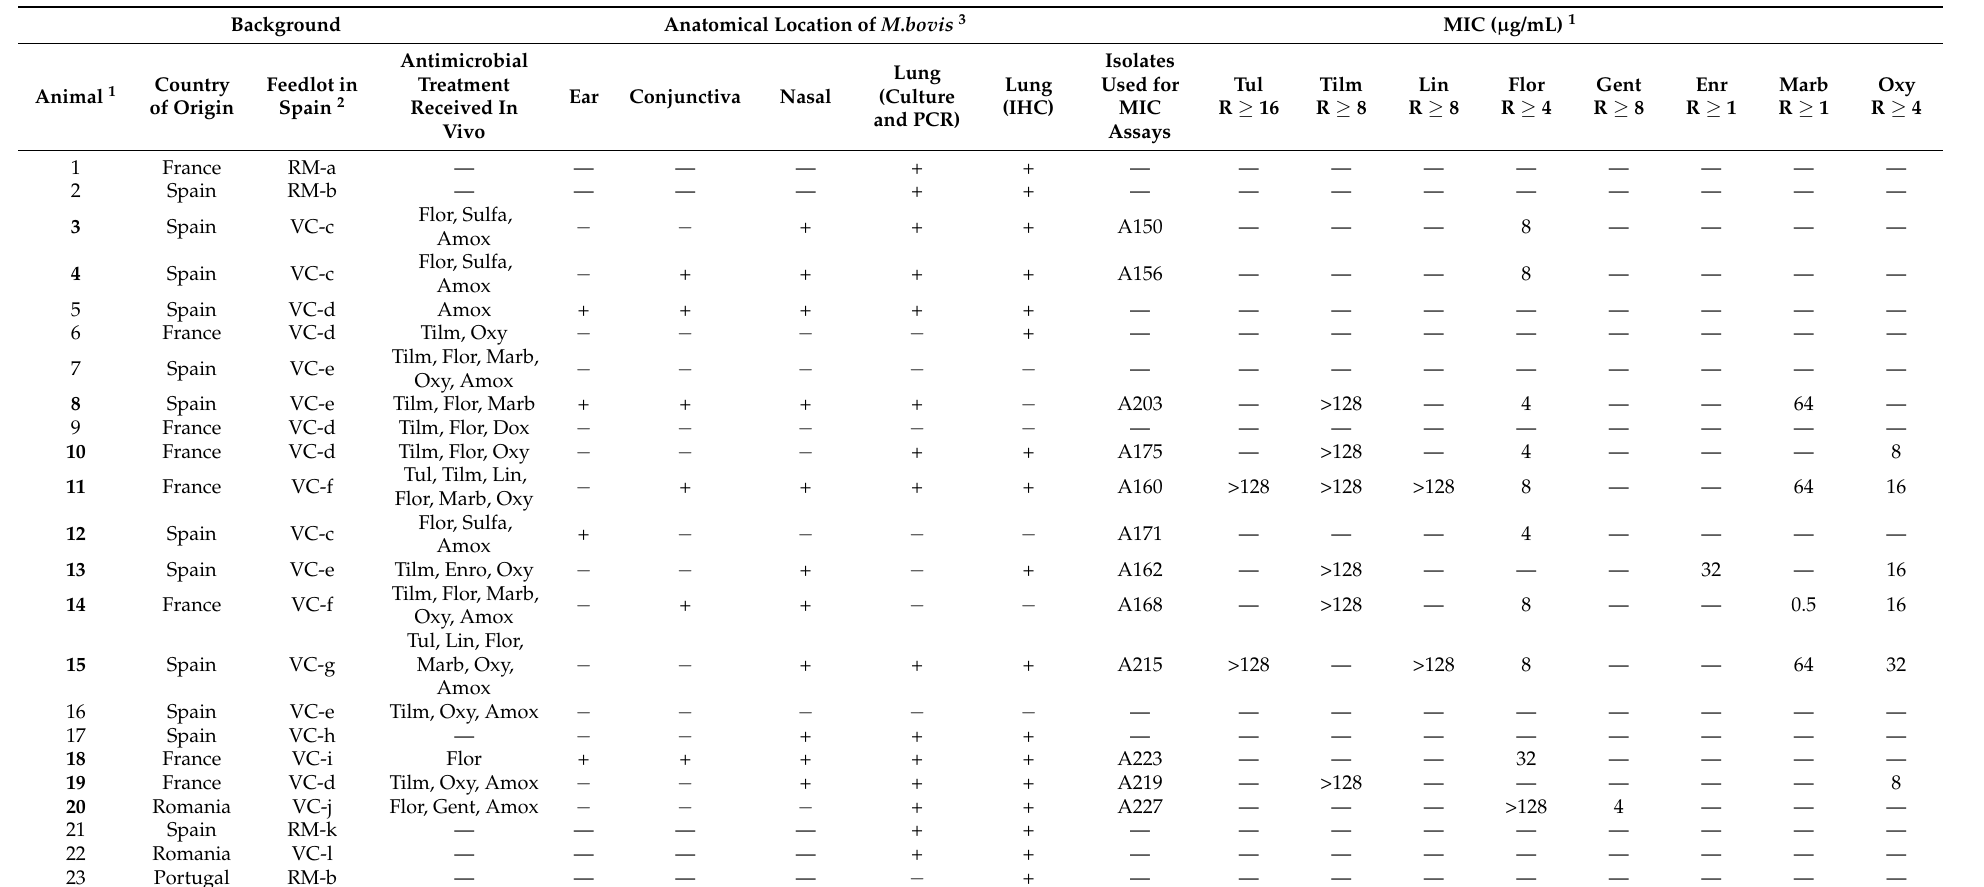
Table 1. Epidemiological background of the animals, anatomical location of Mycoplasma bovis and minimum inhibitory concentration (MIC)